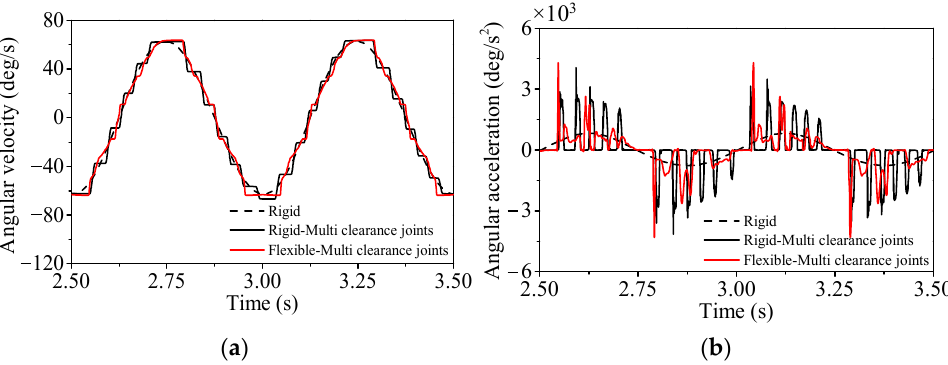
Figure 23. Coupling effects of four clearance joints and three flexible bodies: ( a ) angular velocity; ( b ) angular